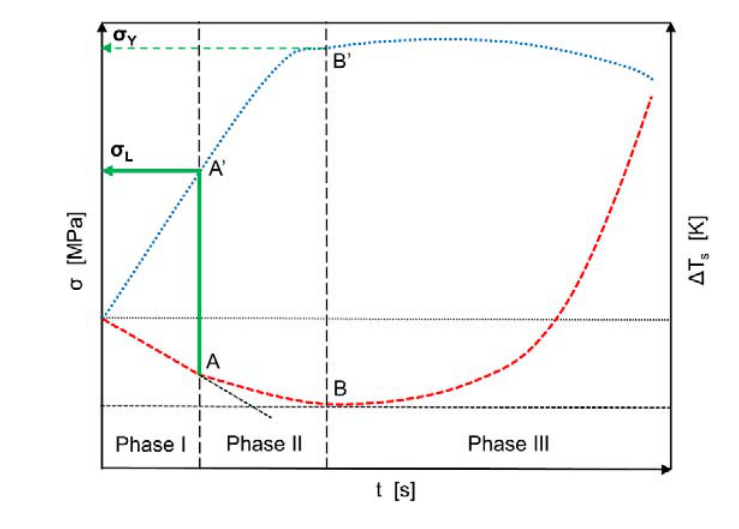
Figure 1: Qualitative Δ T s trend vs machine time (t) vs applied stress ( σ